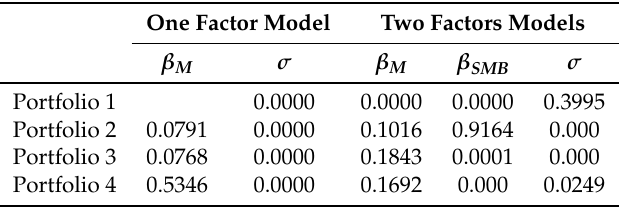
Table A3. P -value of structure change tests.